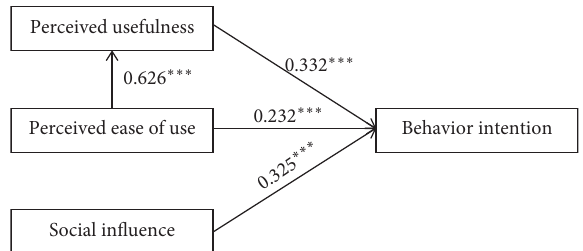
Figure 6: Results of the relationships in the research model.